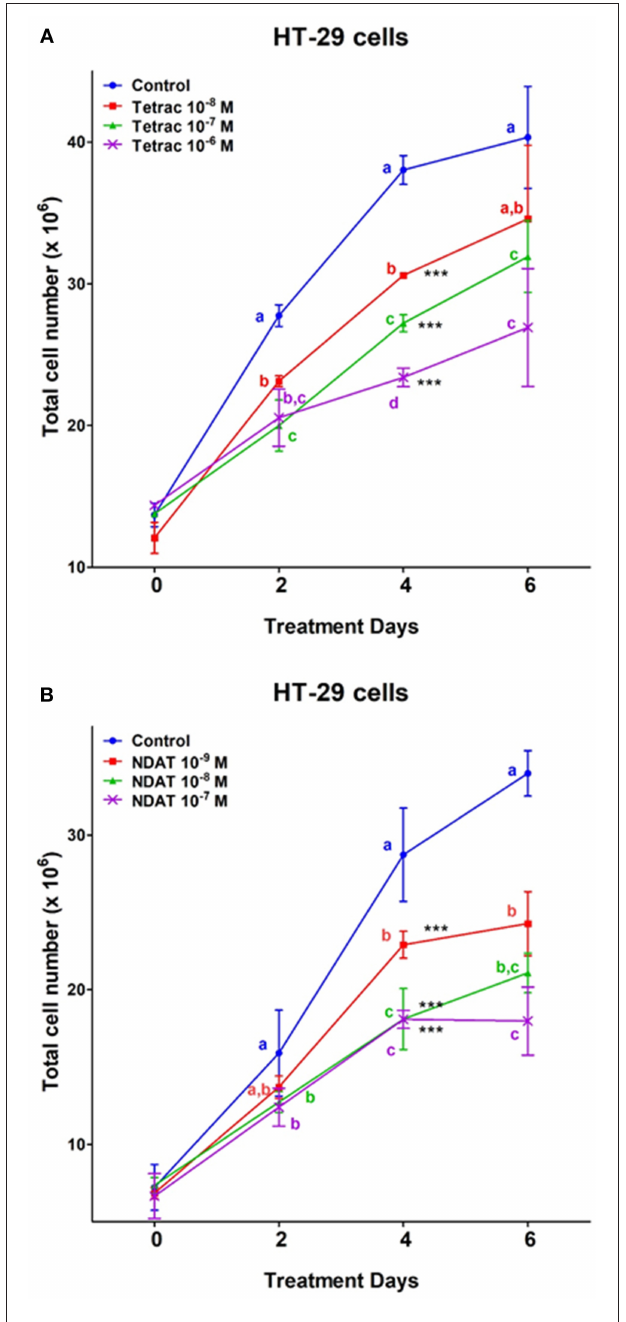
FIGURE 3 | Tetrac (A) and NDAT (B) induce anti-proliferation of K-RAS wild-type colorectal cancer HT-29 cells. HT-29 colorectal cancer cells were grown in the perfusion bellows system and treated with tetrac (10 − 8 to 10 − 6 M) or NDAT (10 − 9 to 10 − 7 M) for 6 days. After incubated in the treatment, cells were isolated and subjected to analysis by cell count, N = 3. Data are expressed as mean ± SD; *** p < 0.001, compared with untreated control. a–c: the subsets after post hoc analysis after the significant differences were obtained using one-way ANOVA.